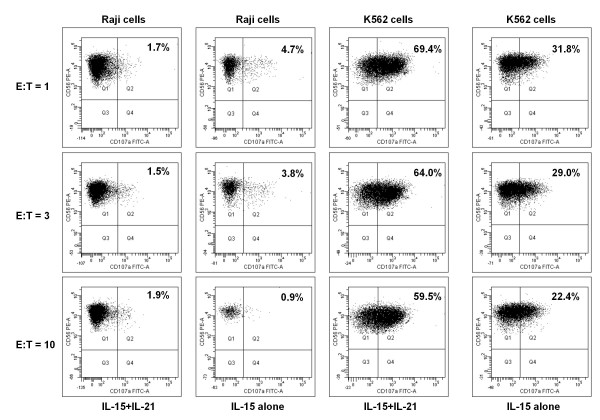
Degranulation assay with cytokine-differentiated NK cells. NK cell function was evaluated through flow cytometry monitoring of CD107a expression, following a previously described protocol [26]. CD34-lineage- cells initially differentiated with either IL-15 alone or the combination of IL-15 and IL-21 for 4 weeks were further activated for 24 hours with 100 IU/ml IL-2 (R&D Systems), followed by co-culture with NK-sensitive cells (K562) or NK-resistant cells (Raji). The different effector (E)-to-target (T) ratios indicated in the Figure were selected based on previous publications [26]. After 4 hours, cells were harvested, labeled with anti-CD107a and anti-CD56 mAb and analyzed by flow cytometry. The data shown here are representative of 4 independent experiments with similar results. The percentage of CD107a+CD56+ cells is indicated.